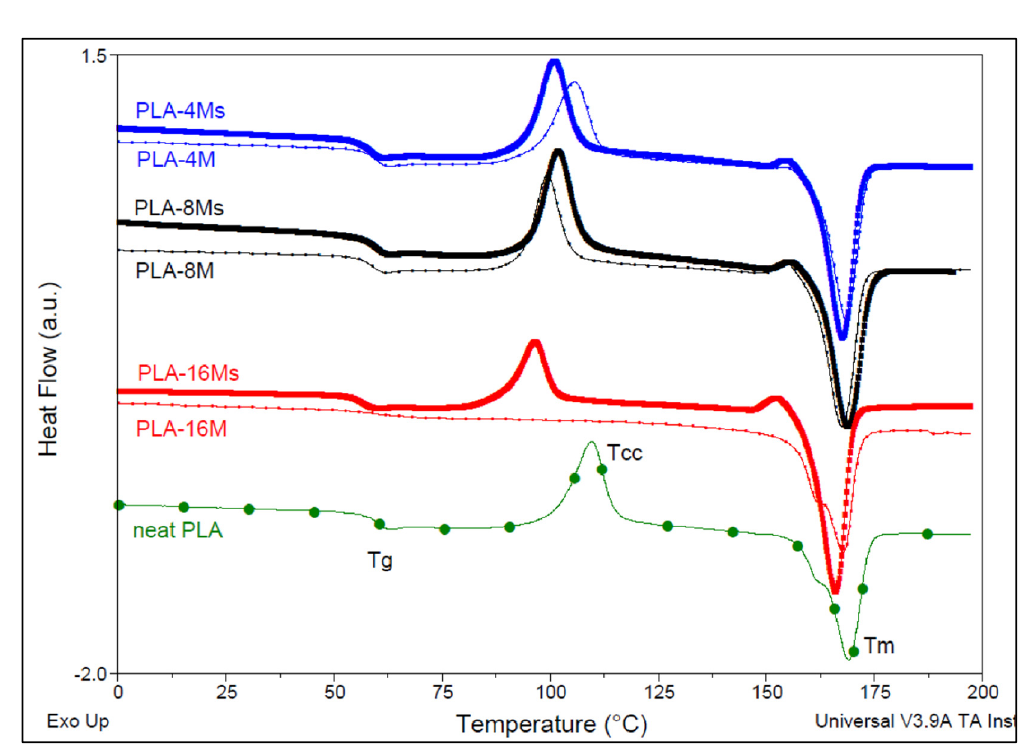
Figure 7. Comparative DSC traces of neat PLA and of PLA–magnetite nanocomposites with similar loadings of nanofiller (second DSC heating, 10 °C/min).